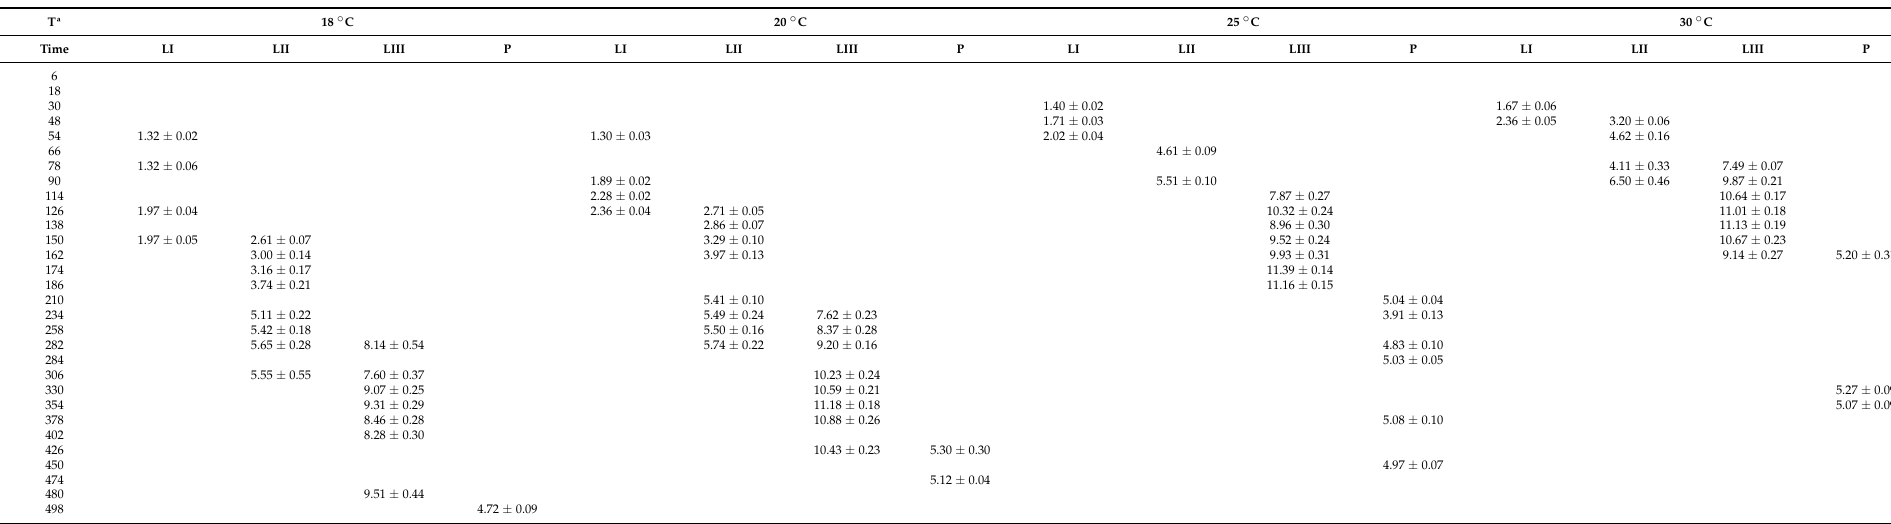
Table A2. Changes in H. capensis larval body length (mm) (average ± standard deviation, SD) overtime under different constant